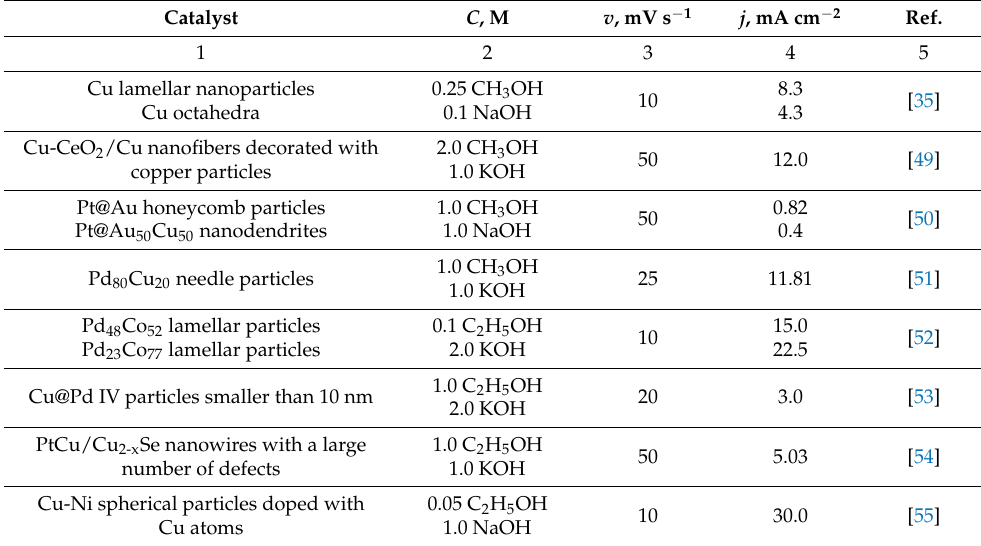
Table 1. Comparative characteristics of the developed catalysts with literature